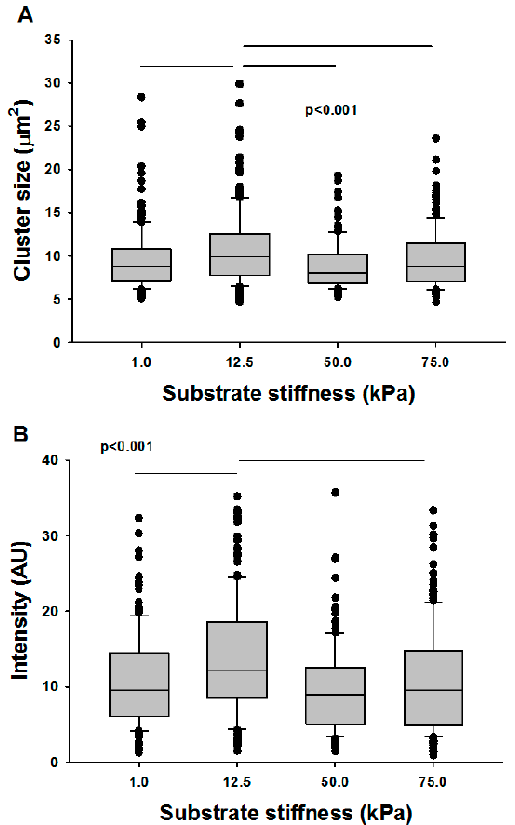
Figure 5. Mitochondrial structure-function relations as a function of substrate stiffness. VSMCs were seeded on substrates of different stiffness, labeled with TMRM, and cluster sizes and mean intensities were measured. The horizontal lines in the boxes are the median, the box represents the 25th percentile, and the horizontal bars are the 75th percentile of the data. The symbols are data outside the 75th percentile. ( A ) Cluster sizes were stiffness dependent, but only the clusters on 12.5 kPa stiffness were different from the rest. ( B ) Intensities were also stiffness dependent, and again only data on 12.5 kPa stiffness were different from the rest.